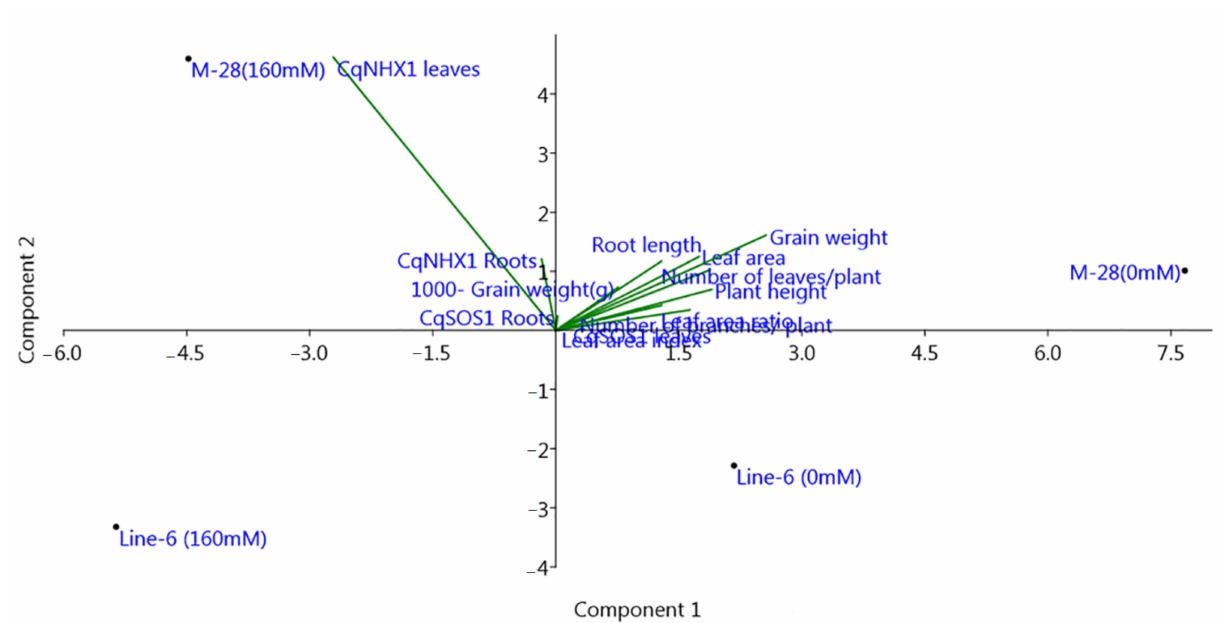
Figure 10. Principal component analysis (PCA) of some morpho-physiological traits and relative gene expressions for M-28 and Line-6 genotypes under salinity stress. The first component demonstrated variance of 74.155% and the second component demonstrated variance of